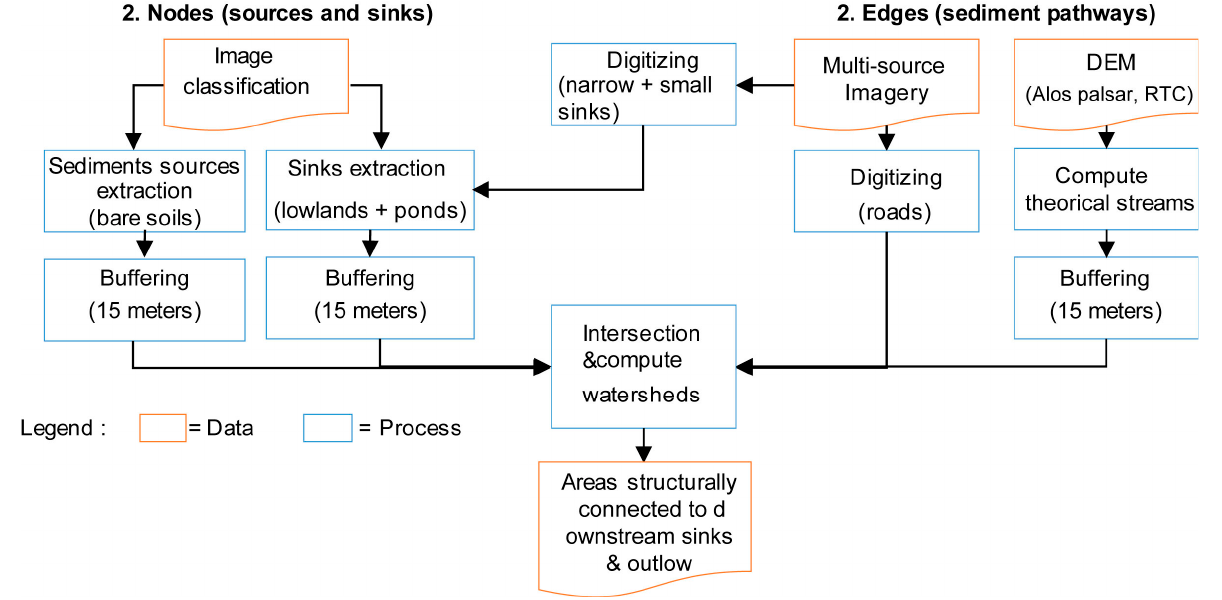
Figure 4. Flowchart to de fi ne the structural connectivity model.